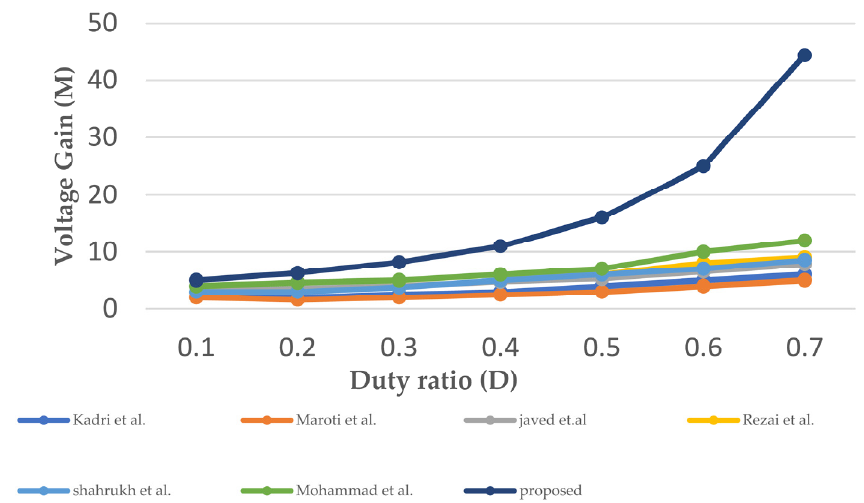
Figure 21. Voltage gain vs. duty ratio plot of the recently proposed topology [14,22,34,36,40,45]. Table 5. Comparison of different types of converters in terms of cost, voltage stress, and efficiency.